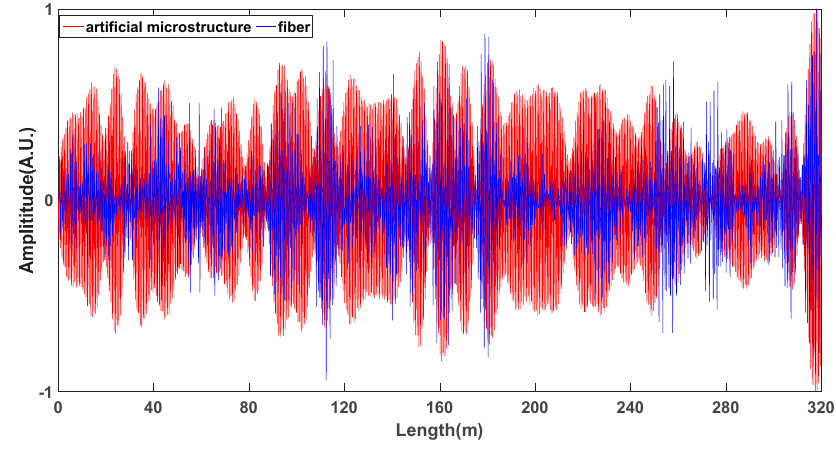
Figure 17 The beat frequency signal. Figure 17. The beat frequency signal.